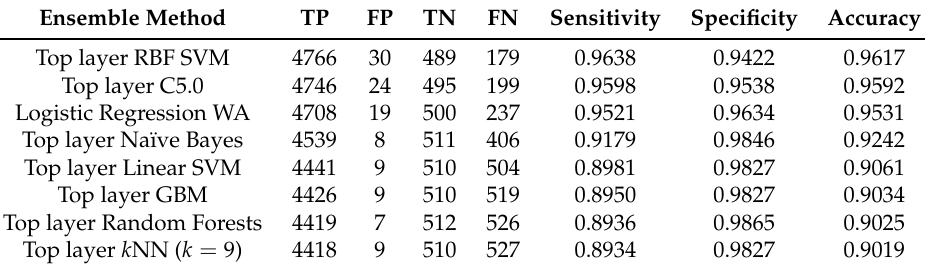
Table 5. Summary of results using an ensemble of both